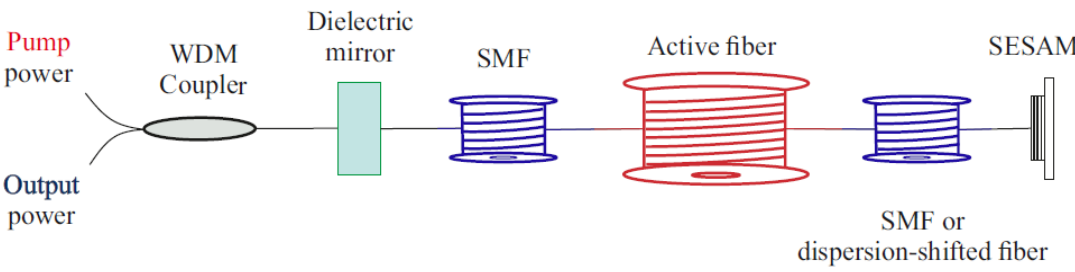
Figure 13. Typical linear mode-locked fiber cavity using SESAM.